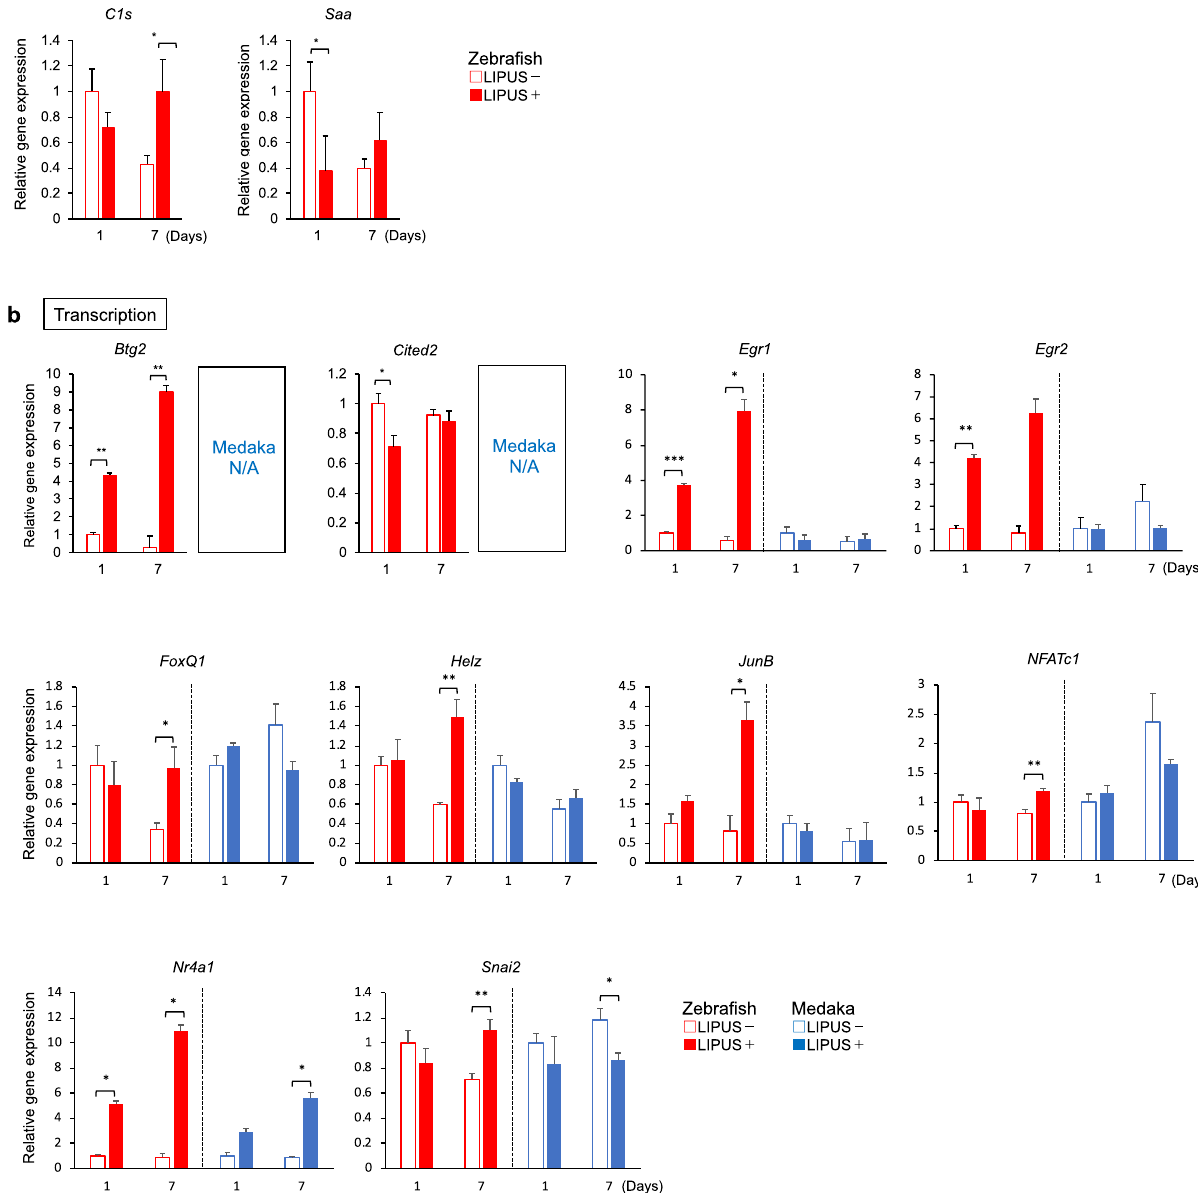
Figure 3. Measurement of candidate gene expression in LIPUS-treated zebrafish and medaka. Zebrafish and medaka tail bones were fractured and stimulated with LIPUS for 20 min every day. On days 1 and 7 after the fracture, RNA was extracted from the fin rays. ( a ) Immunity-, Secretion-, and ( b ) Transcription-related genes were measured (n = 3). For medaka, Btg2 and Cited2 couldn’t design qPCR primers because reference sequences were not available (N/A) in the public database. Values presented are the mean ± SEM and the significance of differences was determined using Student’s t -test. * p < 0.05; ** p <